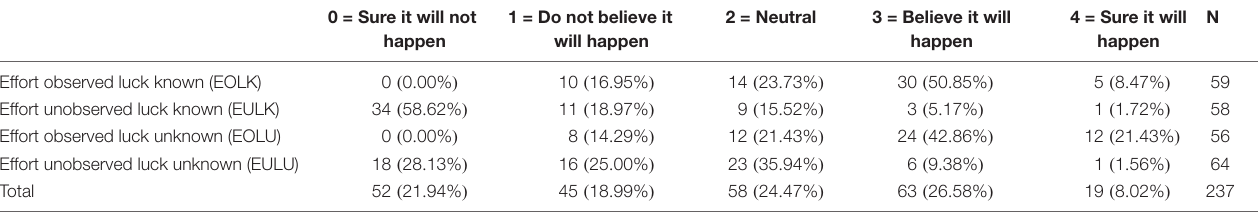
TABLE 3 | Belief about whether the employer will reward effort.